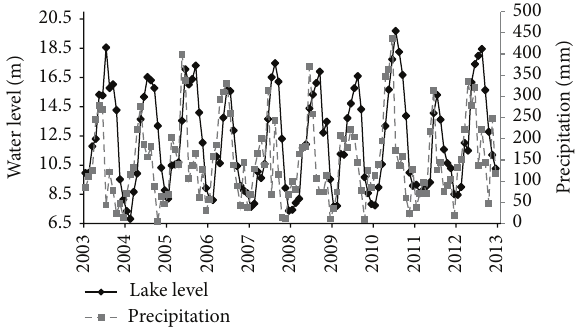
Figure 2: Monthly variations of lake level and precipitation in Poyang Lake Basin during